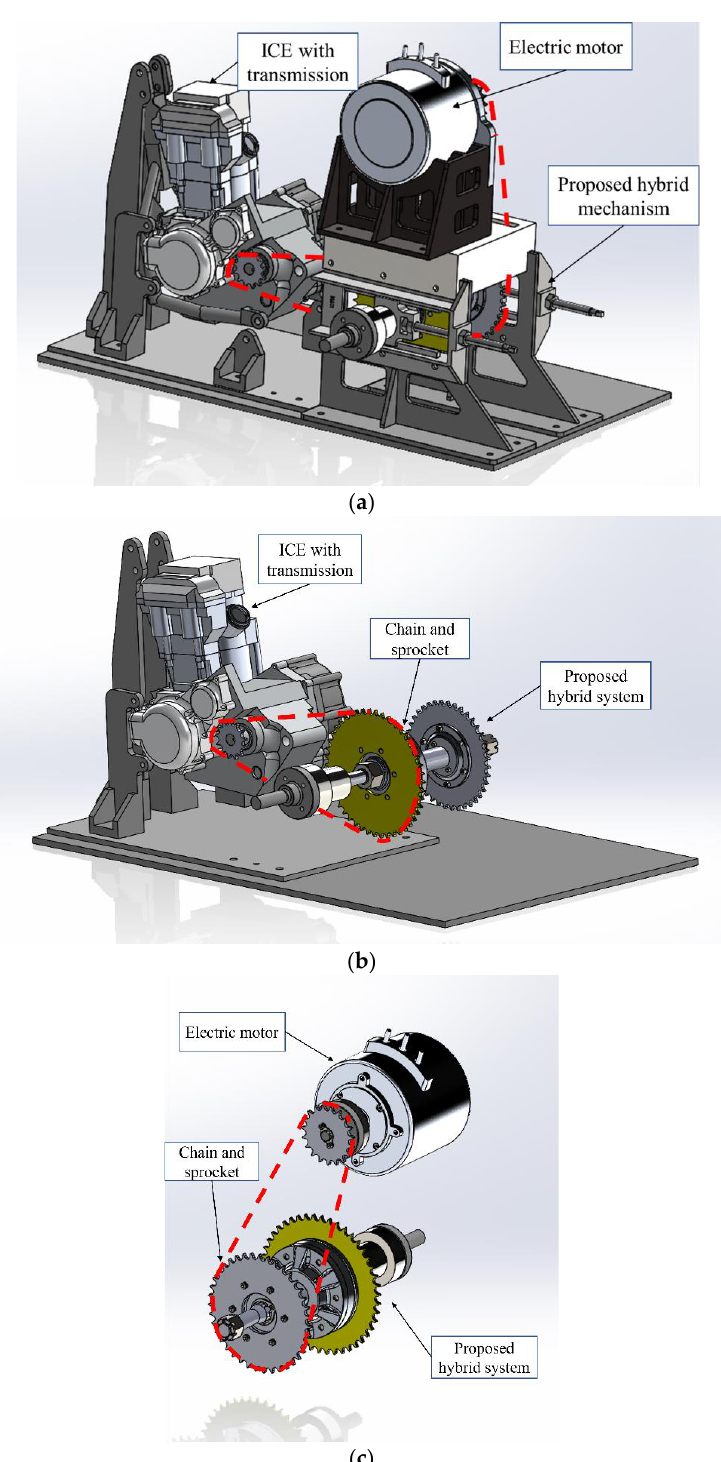
Figure 3. 3D model of the hybrid system. ( a ) Brids view. ( b ) Connection between the ICE and proposed hybrid mechanism. ( c ) The connection between the electric motor and the proposed hybrid